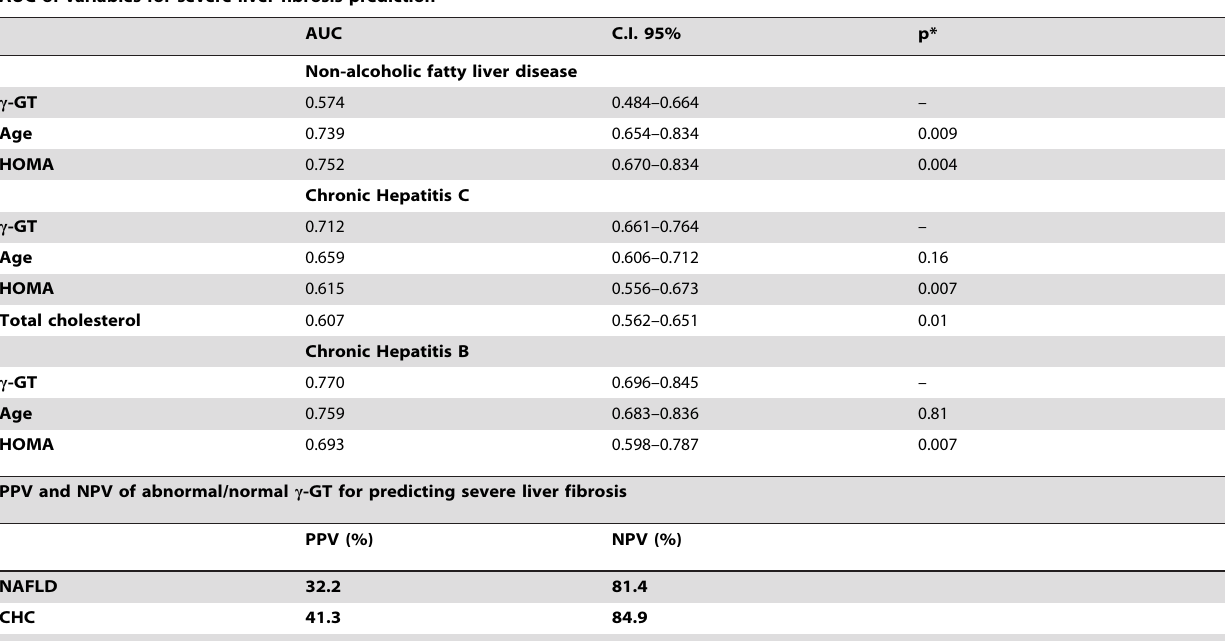
Table 3. Diagnostic performance of GGT in predicting severe liver fibrosis.